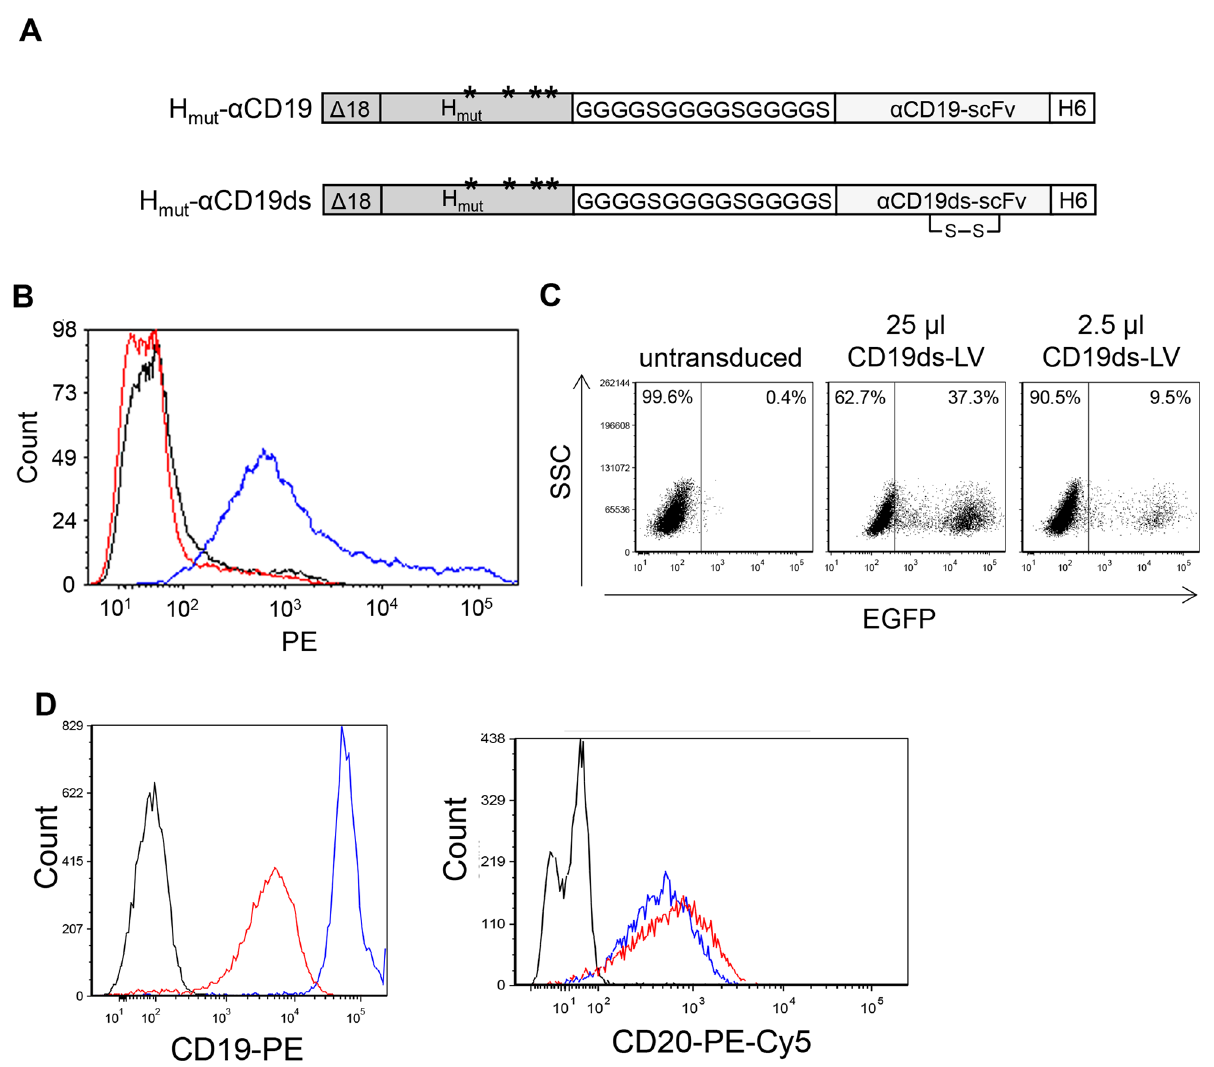
Figure 1. A stabilizing disulfide bond in a CD19ds-scFv is essential for generating CD19 targeting vectors. ( A ) Schematic drawing of the cytoplasmic tail-truncated hemagglutinin envelope proteins displaying two a CD19 single-chain antibody (scFv) variants. In the mutated hemagglutinin protein (H mut ) that is derived from the NSe variant of the measles virus (MV) vaccine strain Edmonston B, mutations in the MV receptor recognition regions Y481A, R533A, S548L and F549S (ectodomain) [12] are indicated by asterisks. A glycine-serine linker ((G 4 S) 3 ) is used as linker region between H mut and scFv. The a CD19-scFv and a CD19ds-scFv differ in the presence of a disulfide bond in a CD19ds-scFv. A histidine tag (H6) is present at the scFv C-terminus. Both hemagglutinin proteins are truncated by 18 amino acids in their cytoplasmic tail ( D 18) to allow incorporation into the lentiviral envelope. ( B ) Cell surface transport of the two different H variants was investigated upon transfection of plasmids pCG-H mut - a CD19 (red line) and pCG-H mut - a CD19ds (blue line) into HEK-293T cells. The empty expression plasmid pCG-1 (black line) was used as control. Forty-eight hours after transfection, the cells were stained with a PE-conjugated anti-His antibody to detect cell surface expression of the H constructs by FACS analysis. The respective histograms are shown. ( C ) To determine the titer of vector particles pseudotyped with H mut - a CD19ds (CD19ds-LV), CD19 + Raji cells were transduced with serial dilutions of the concentrated vector particles. After 72 h, the percentage of EGFP + cells was determined by FACS analysis. ( D ) To determine cell surface down-regulation of CD19 after CD19ds-LV transduction, CD19 + /CD20 + Raji cells were transduced with CD19ds- LV vectors at an MOI of 2 or remained untransduced. Forty-eight hours later, untransduced cells were stained with PE-conjugated anti-CD19 ( left ; blue line) and PE-Cy5-conjugated anti-CD20 ( right ; blue line) antibody, or with the respective isotype controls (black lines). CD19ds-LV transduced cells were stained with PE-conjugated anti-CD19 ( left ; red line) and PE-Cy5-conjugated anti-CD20 ( right ; red line) antibody. Then, CD19 and CD20 cell surface expression was analyzed by